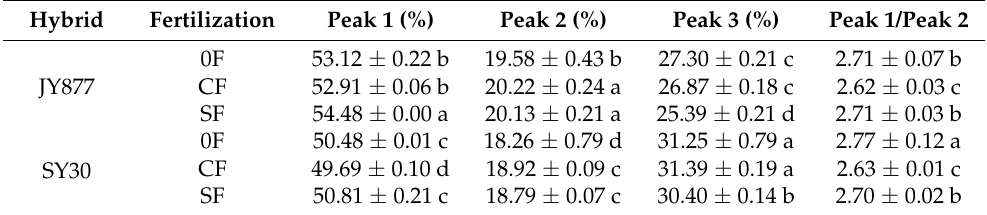
Table 1. Effects of the fertilization mode on percentage of three peaks of isoamylase-debranched starch of normal maize.